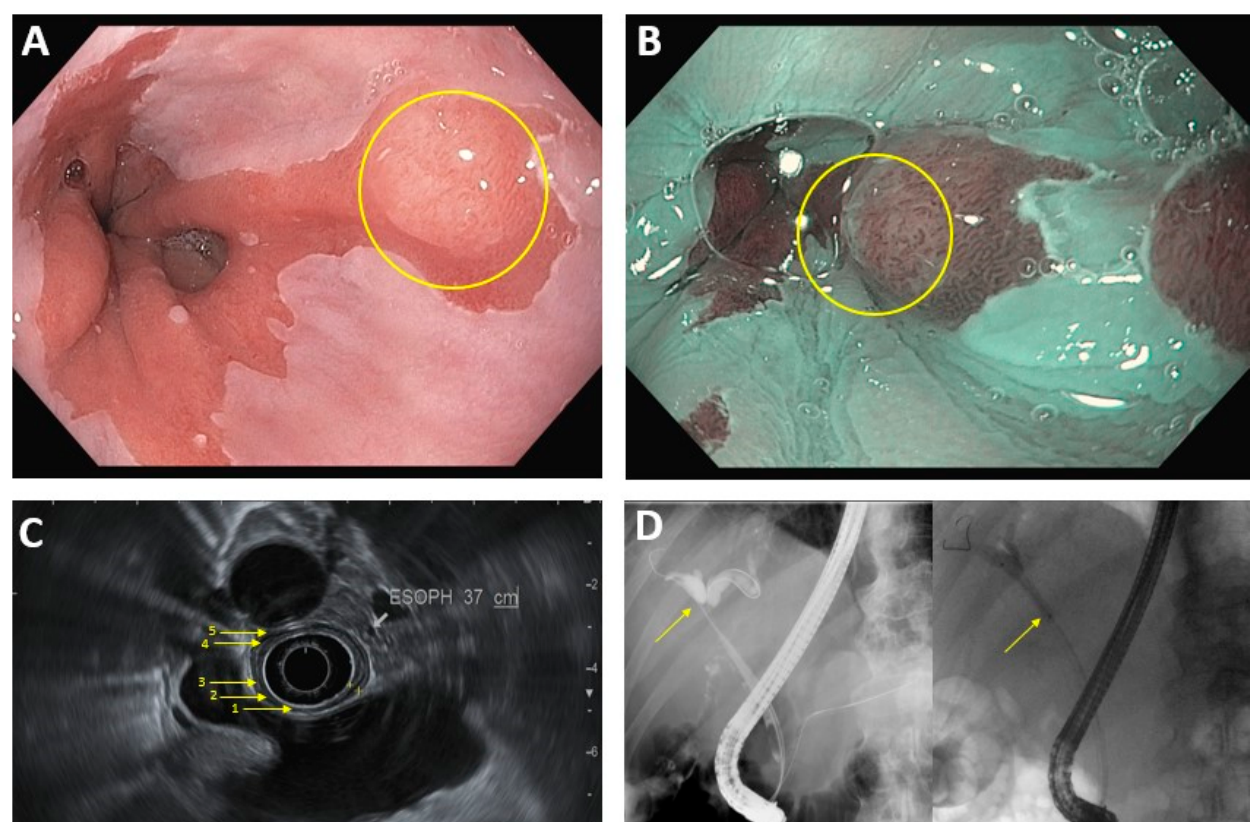
Figure 1: Common endoscopic modalities. A: Conventional HD endoscopy showing Barrett’s esophagus with lesion (circled). B: Image in 1A under NBI. Area of abnormal vascular and mucosal patterns (circled) is concerning for malignancy. C: EUS of the esophagus. Arrows denote 5 alternating hyperechoic/hypoechoic layers: (1) mucosal surface, (2) muscularis mucosa, (3) submucosa, (4) muscularis propia, (5) serosa. D: ERCP in hilar cholangiocarcinoma. Left image: dilation of intrahepatic bile ducts because of complete blockage of the common hepatic duct (arrow). Right image: improved flow of bile/contrast after deployment of plastic biliary stent across the malignant obstruction.